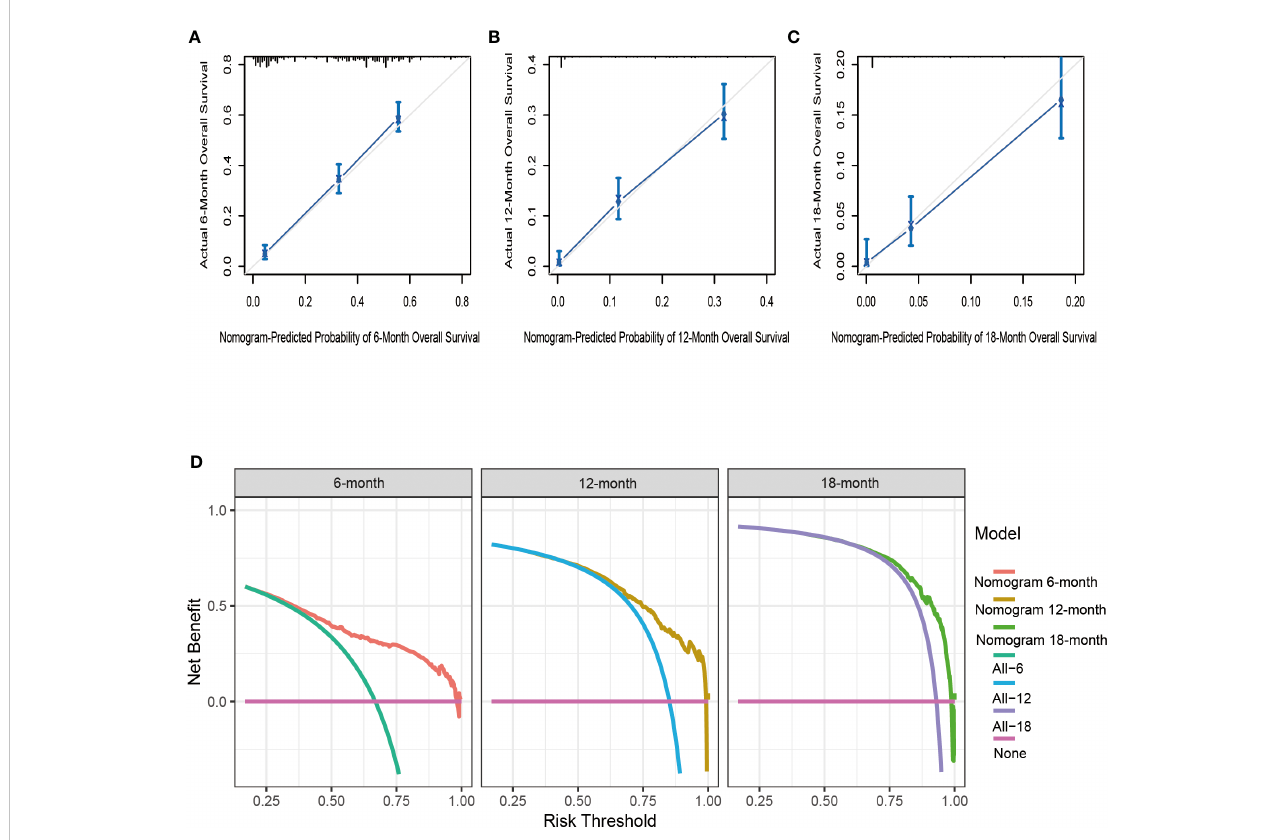
FIGURE 6 The calibration curves of the nomogram for the 6 (A) , 12 (B) , and 18 months (C) in the validation set. The decision curve analysis of the nomogram for the 6, 12, and 18 months in the validation set (D)